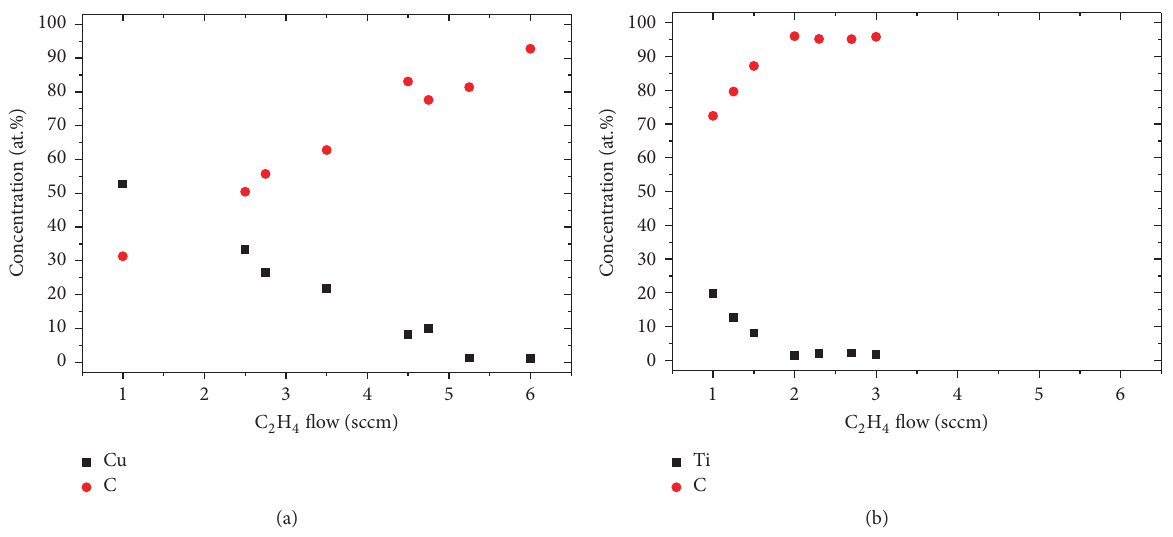
Figure 4: Composition of (a) Cu-DLC and (b) Ti-DLC films as a function of C 2 H 4 flow rate, with a fixed Ar flow rate of 20 sccm.